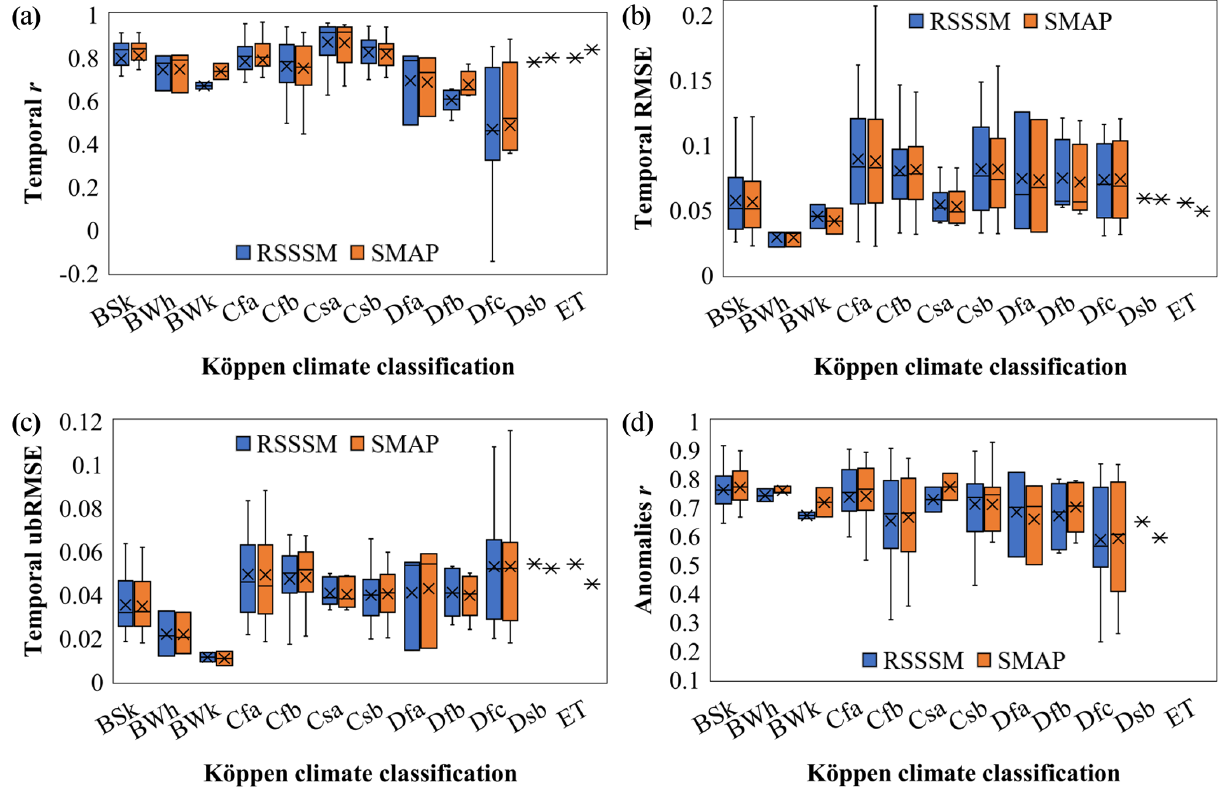
Figure 5. Comparison of the temporal accuracy between RSSSM and SMAP in regions with different Köppen–Geiger climate types. The four indexes are (a) r , (b) RMSE, (c) ubRMSE, and (d) anomalies r (A.R). The lengths of the error bars are 1.5 times that of the interquartile range, while the upper and lower boundaries and the central lines of the boxes indicate the 75th, 50th, and 25th percentile values, with mean values marked by “ × ” (the forms of all the following boxplots are the